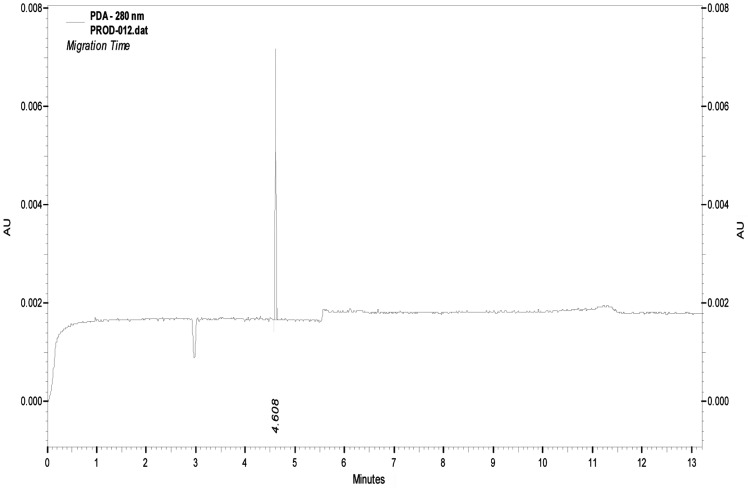
Identification of purified human ugmenter of liver regeneration (hALR) by capillary electrophoresis (CE).